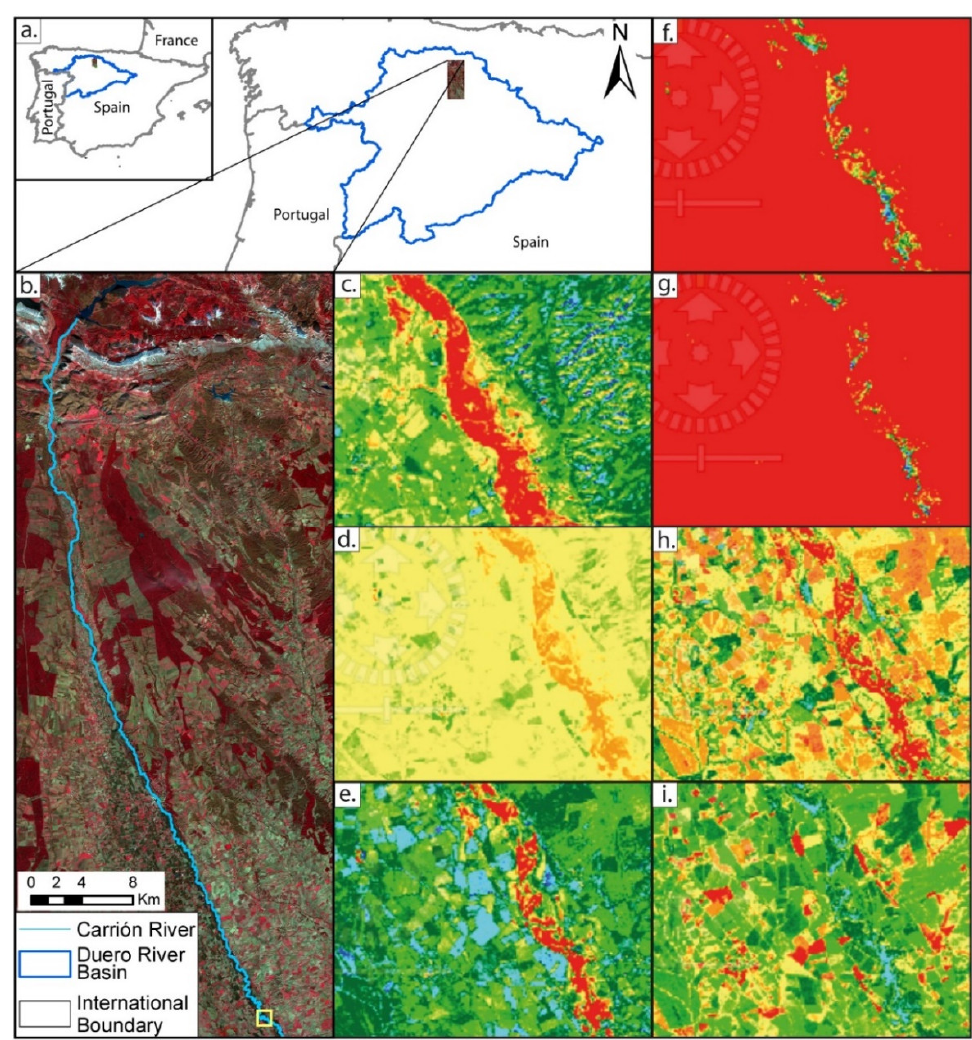
Figure 2. Location of the study area and Spectral indices’ images obtained from Sentinel-2: ( a ) General localization. ( b ) Studied River. ( c ) AWEInsh. ( d ) AWEIsh. ( e ) MNDWI. ( f ) NDPI. ( g ) NDVI. ( h ) NDWI. ( i ) SAVI.